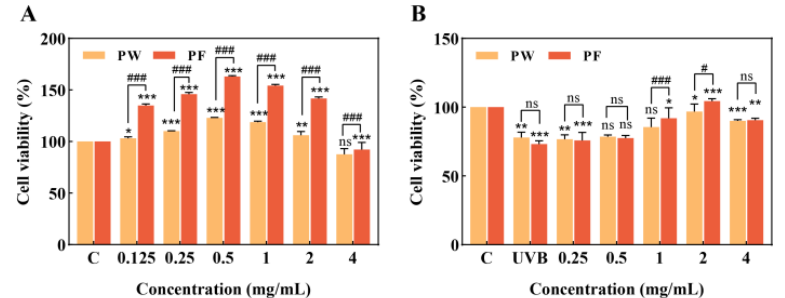
Figure 4. Effects of PW and PF on cell viability. ( A ): Effects of PW and PF on cell viability at different concentrations. ( B ): Effects of PW and PF on cell viability at different concentrations after UVB-induced damage. PW: Passiflora edulis Sims peel water extract. PF: Passiflora edulis Sims peel fermentation broth. Each value is expressed as mean ± SD ( n = 3). (*: p < 0.05, **: p < 0.01, ***: p < 0.001, ns > 0.05, versus control group; #: p < 0.05, ###: p < 0.001, ns > 0.05, versus PW group).